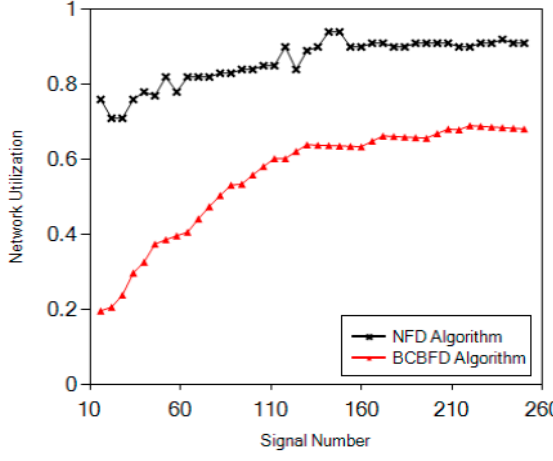
Appl. Sci. 2018 , 8 , x FOR PEER REVIEW Figure 7. Comparison of network utilization. Figure 7. Comparison of network utilization. Figure 7. Comparison of network utilization.